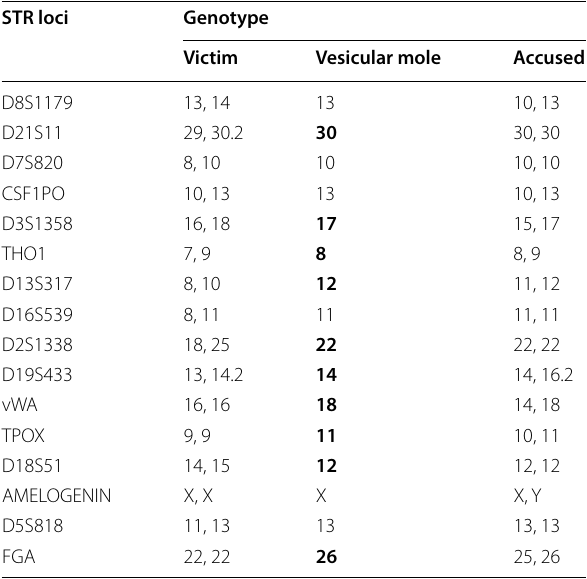
Table 2 Genotypes of blood samples of victim, accused, and vesicular mole STR